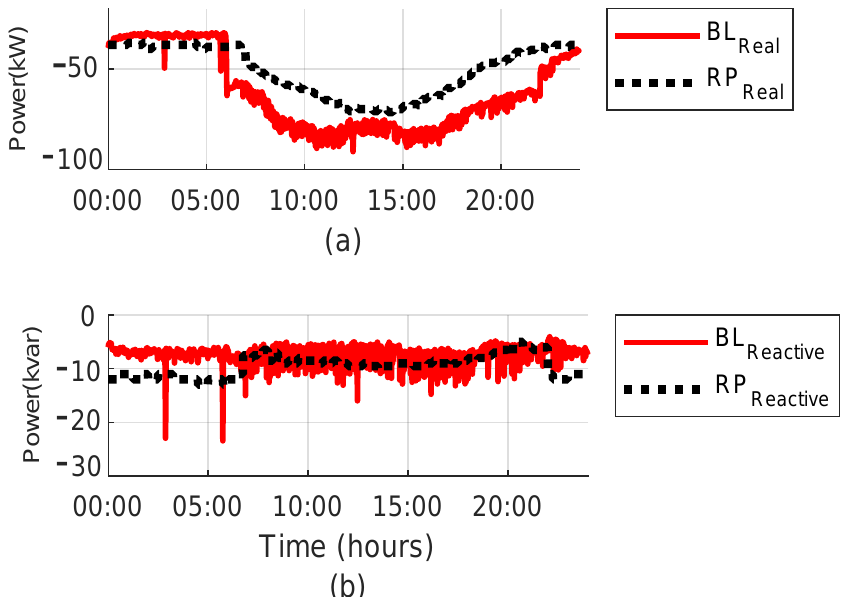
Figure 5. PV forecast comparison.